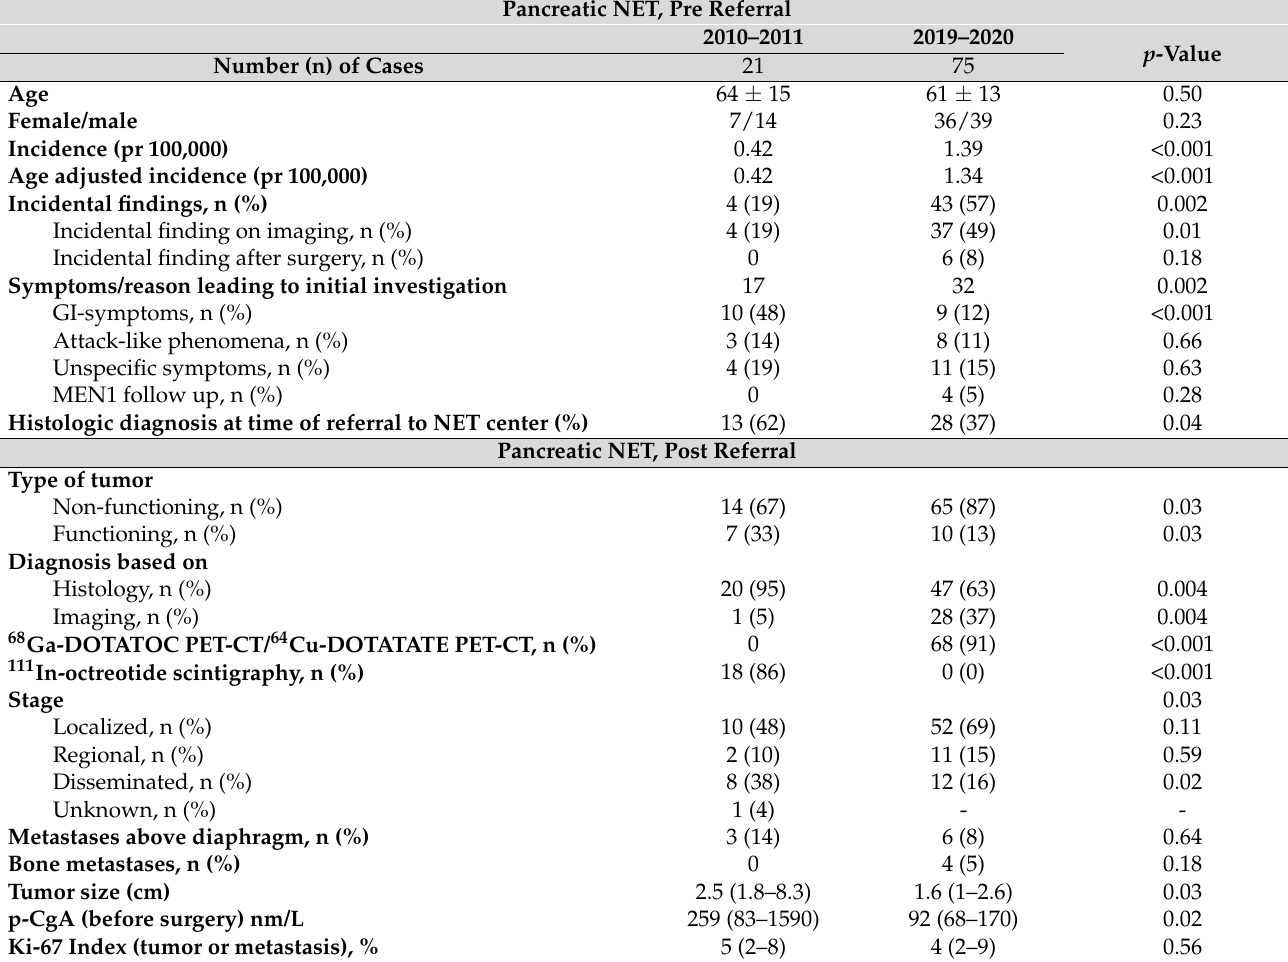
Table 2. Baseline characteristics of pancreatic NET